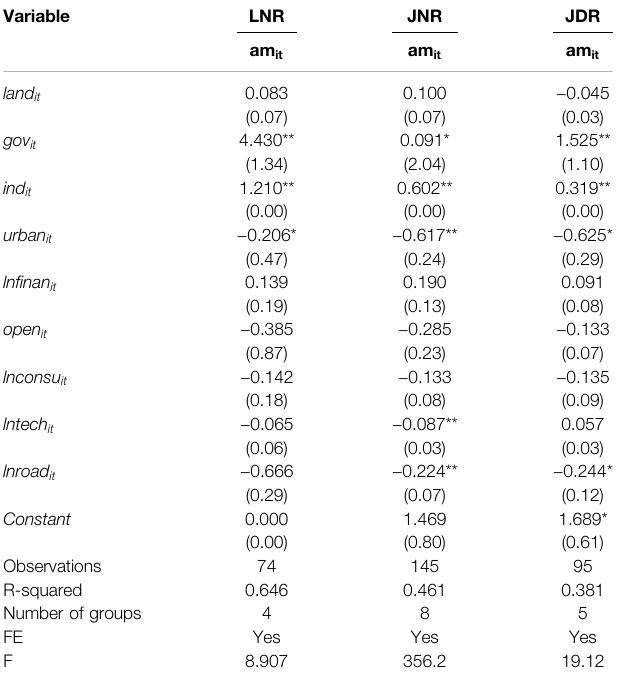
TABLE 3 | Regional heterogeneity effects of the multidimensional contributing factors of the SMCL.